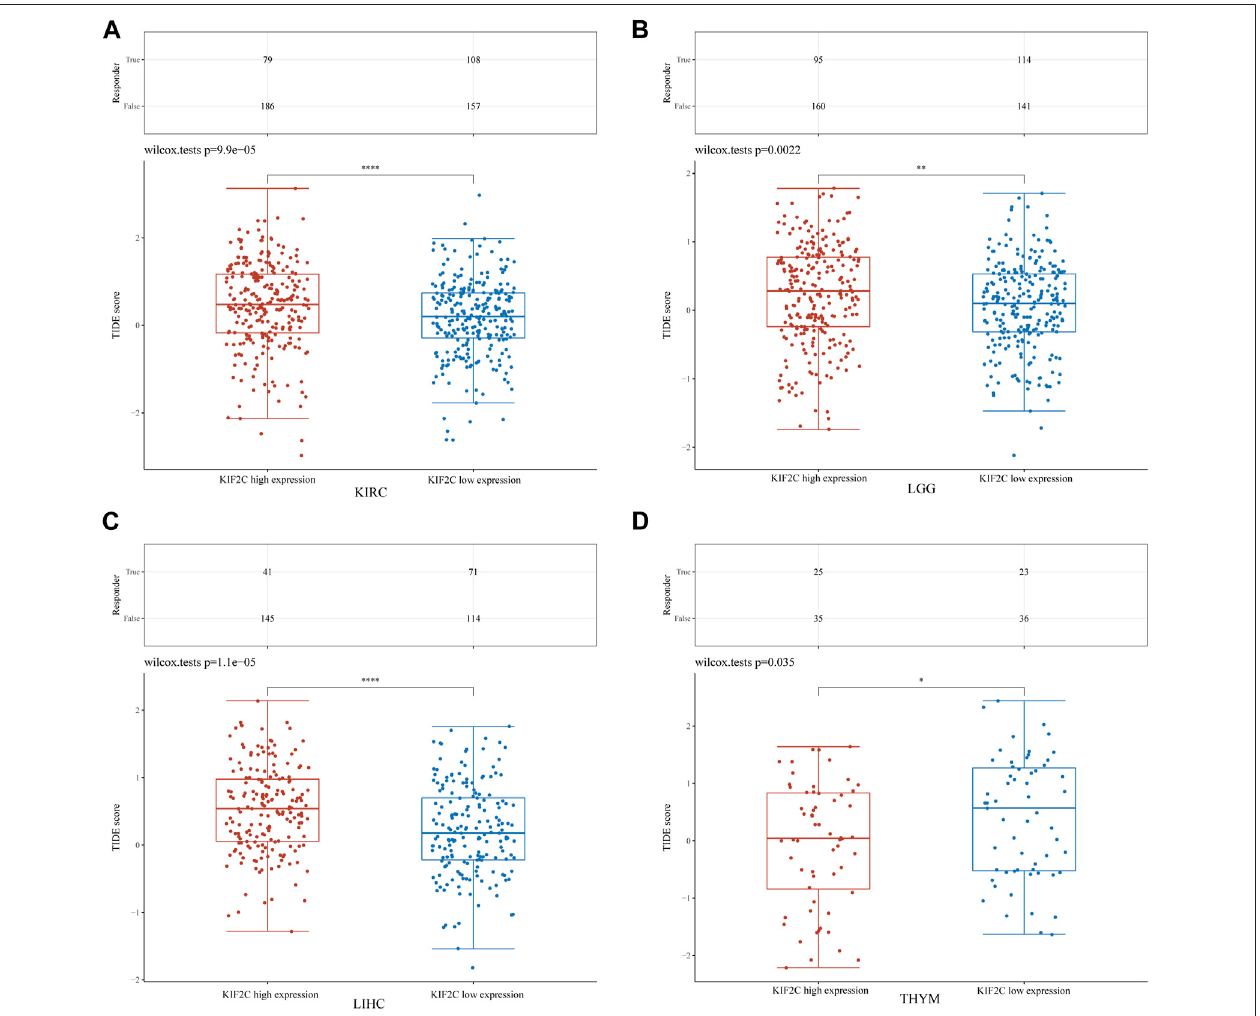
FIGURE 9 | (A – D) TIDE score of KIF2C high and low expression groups in KIRC, LGG, LIHC, and